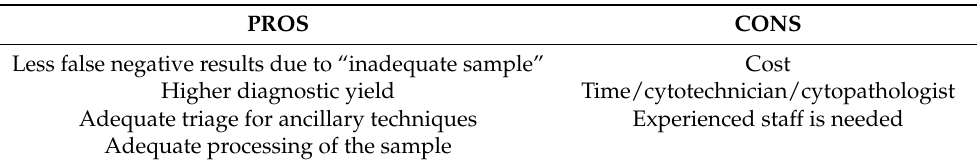
Table 1. Main advantages and disadvantages of Rapid On-Site Evaluation (ROSE).